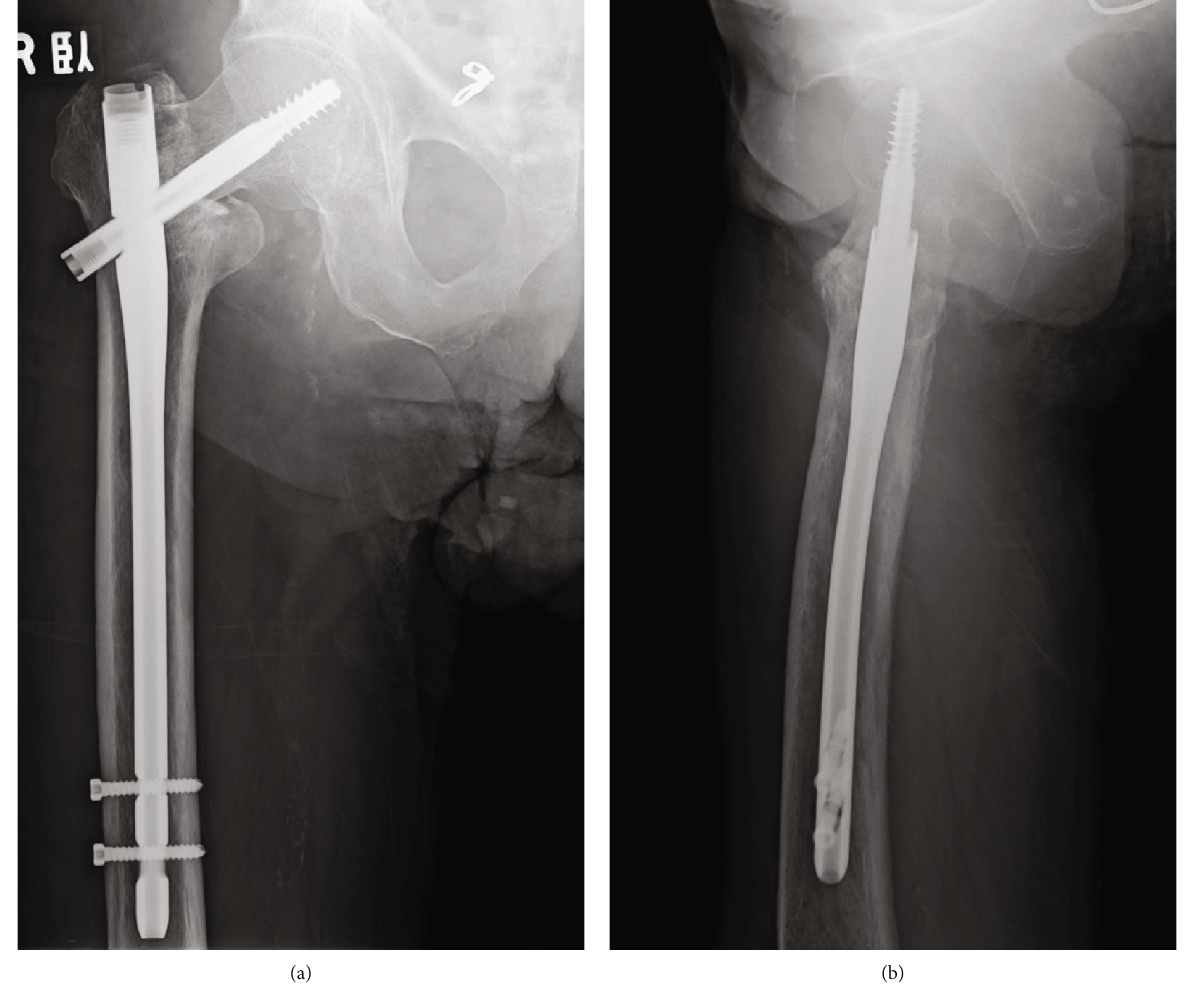
Figure 2: Radiographs after the osteosynthesis of the right trochanteric fracture. Anteroposterior (a) and lateral (b) views of the right femur showing insu ffi cient reduction and poor placement of the lag screw after implantation of a gamma 3 long